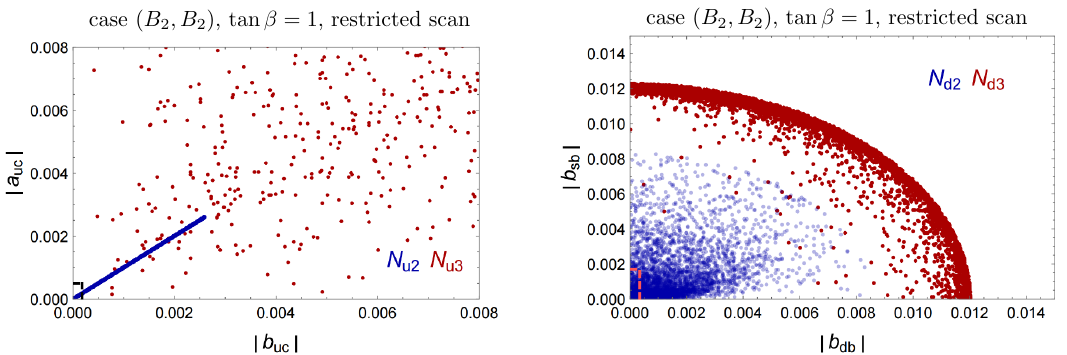
case ( B 2 ,B 2 ), tan β = 1, restricted scan